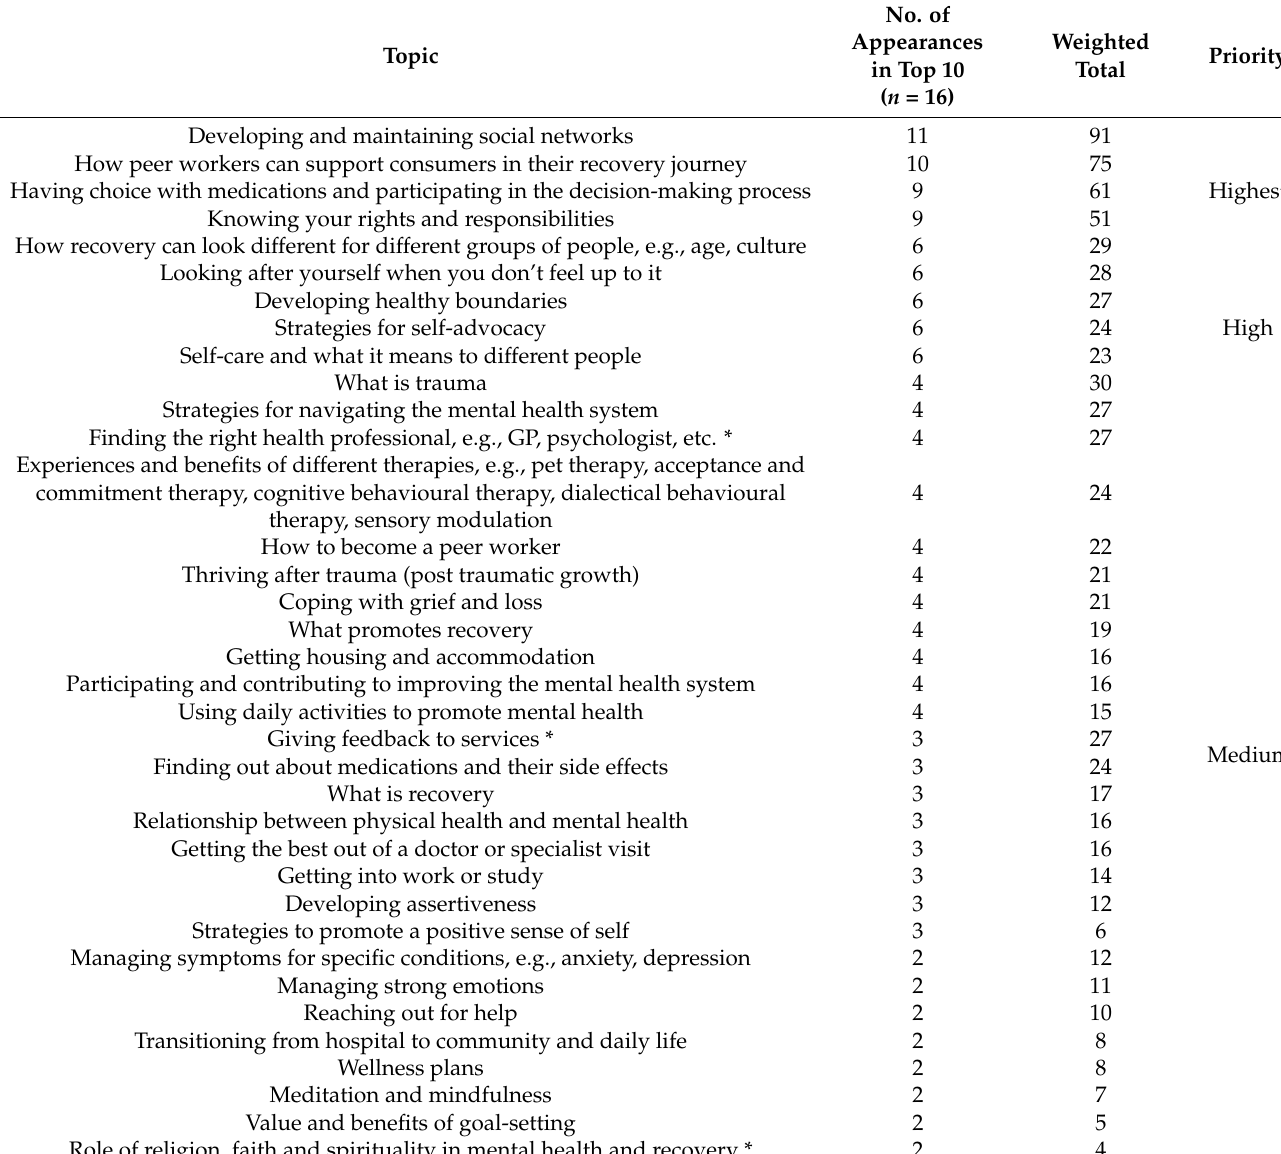
Table 2. List of lived experience research topics by